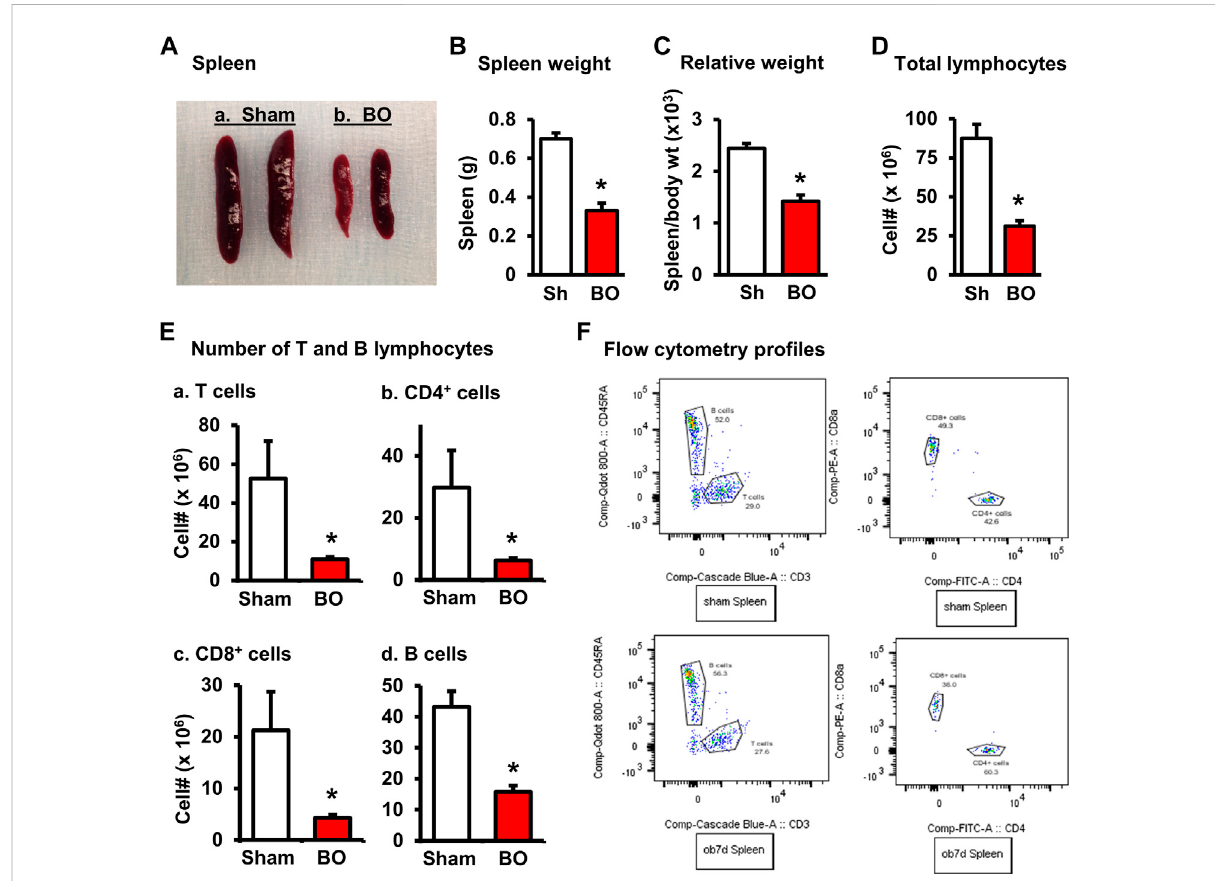
FIGURE 1 Effectofbowelobstructiononthespleen. (A) Isolatedspleensfrom2shamrats(Sh)and2ratswithbowelobstruction(BO)for7 days. (B) Weight of spleens in Sh and BO rats. (C) Relative weight of the spleen [ratio of spleen weight/body weight (x 10 3 )]. (D) Total live cells. (E) Numbers of T and B lymphocytesin thespleen. (A) . Total Tcells (CD3 + ); (B) . CD4 + Tcells (CD3 + /CD4 +) ; (C) . CD8 + Tcells (CD3 + /CD4 + ); (D) .B lymphocytes (CD45RA + ). (F) Representative fl ow cytometry pro fi les for B and T lymphocytes in sham (upper left) and BO rats (down left), and CD4 + and CD8 + cells in sham (upper right) and BO rats (down right). N = 9 per group for B and (C) . N = 5 or 6 per group in D and (E) . * p < 0.05 vs. sham. Sh, sham. BO, bowel